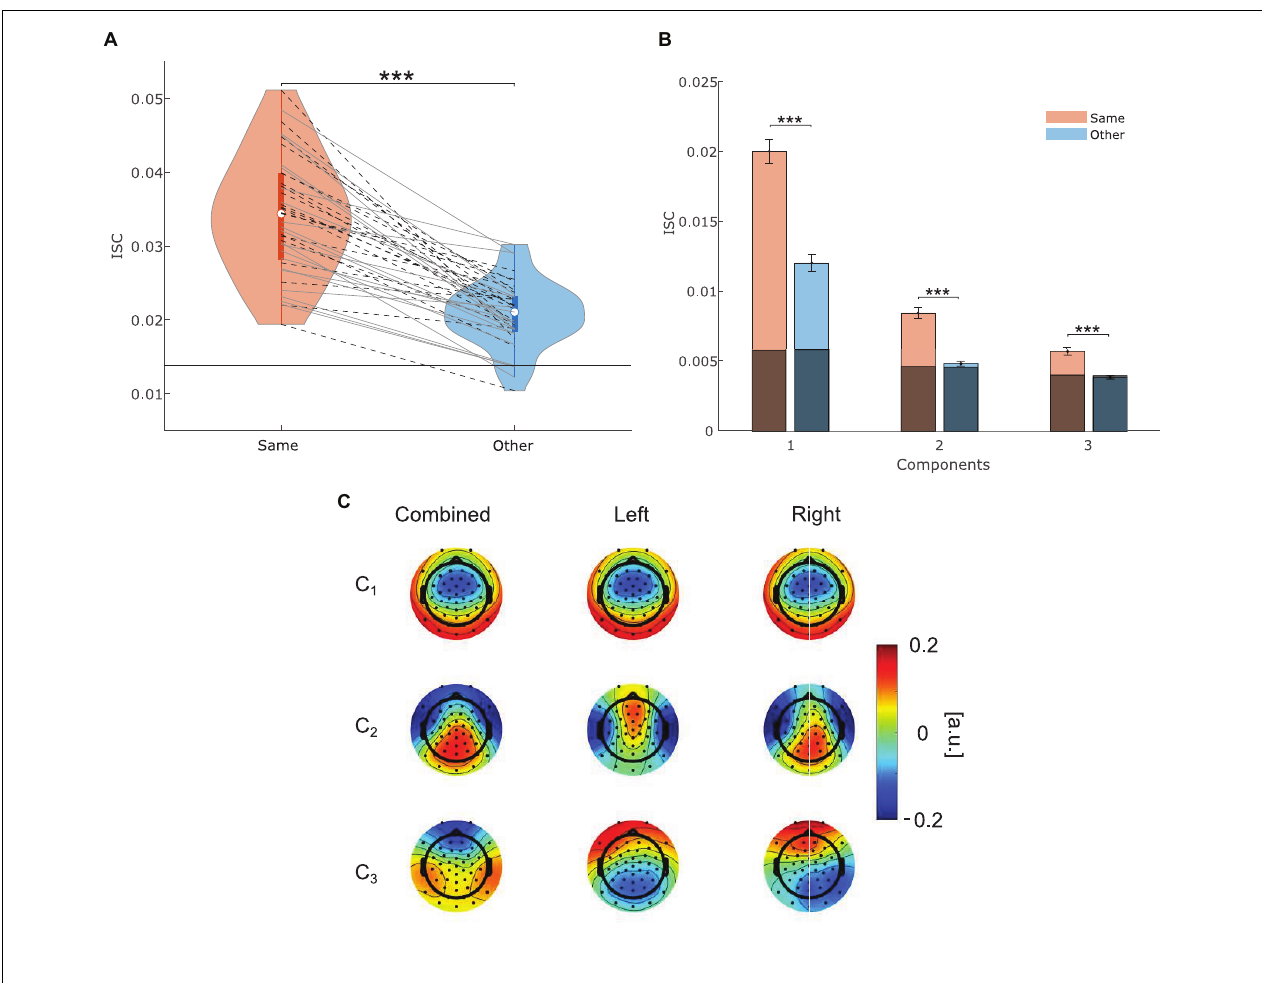
FIGURE 3 | (A) Individual ISC scores between participants within the same attentional condition (red), and other attentional condition (blue). Participants from the freefield and headphone study are marked with solid gray and dashed black lines, respectively. The horizontal black lines represent 95th percentile of chance-level ISC scores for the same and other group correlation, respectively. (B) Mean and standard error of the mean (SEM) of intersubject correlations within a condition (same) and across conditions (other) for each component. 95th percentile of chance-level correlations is marked in gray. *** indicates significance at p < 0.001. (C) Forward model of the three most correlating components. The rows represent each component starting from the strongest in descending order. The first column contains data from all participants combined. The second and third column exclusively contain data from participants that attended to the left or right story, respectively. Channel weights which indicate channels that contribute most to the correlations between participants are indicated by color.